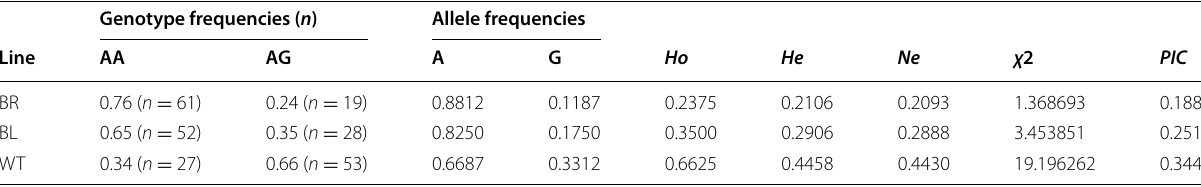
Table 3 Genotype and allele frequencies and genetic diversity variables for p.F79 Japanese